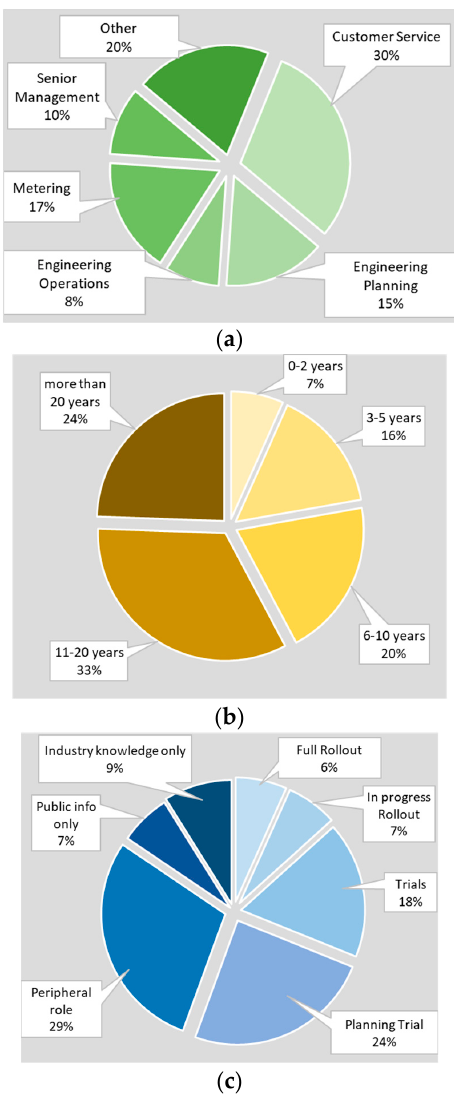
Figure 1. Profiles of first structured interview respondents: ( a ) The business area experience of interviewed water-industry staff; ( b ) the years of water-industry experience; and ( c ) the levels of knowledge of digital water metering through rollouts, trials, and public information.